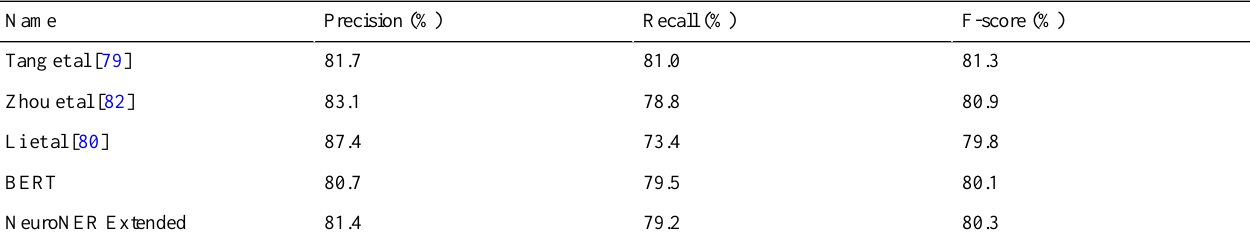
Table 19. Task 1W biological cue-level detection (BioScope).